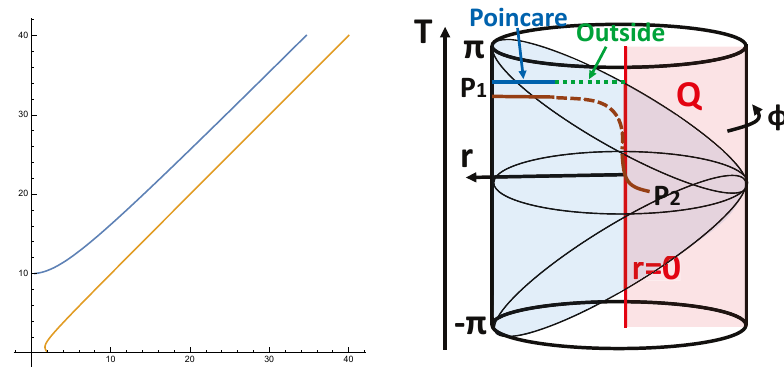
Figure 22 . Pro(cid:12)les of the geodesic. In the left graph, we show the geodesic (blue) and the boundary surface Q (orange) in the Poincar(cid:19)e coordinate ( z; t ) with t 0 = 10 and (cid:11) = 1. The right picture shows the outside part of the disconnected geodesic L outside (green dotted line) as well as the one in the Poincar(cid:19)e patch L poincar(cid:19)e (blue line) in the global AdS coordinate. The point P 1 is situated at 0 < x (cid:28) t , while the point P 2 is at 0 < t (cid:28) x . The blue region corresponds to the Poincar(cid:19)e patch. The red vertical line is the tip (6.2) of the boundary surface Q . The brown curve describes the connected geodesic that corresponds to